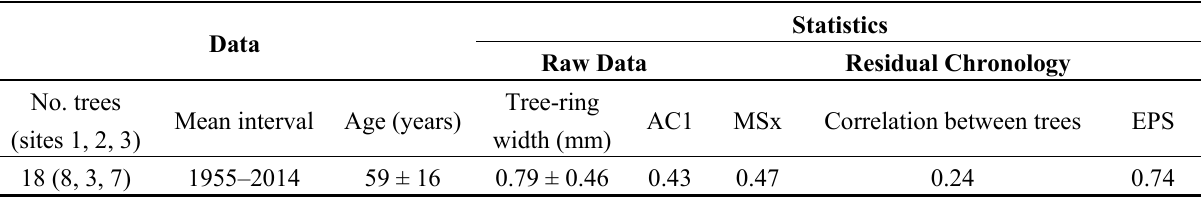
Figure 7. Responses of tree-ring width indices (period 1960–2014) to climate: monthly mean maximum (TMx) and minimum (TMn) temperatures and total precipitation ( a ), the SPEI drought index calculated for 1–16-month-long scales ( b ) and daily climate data averaged (temperatures) or summed (precipitation) for 5-, 15- and 25-day-long scales ( c ). All plots show Pearson correlations. In figures ( a ) and ( c ) the dashed and dotted lines indicate 0.05 and 0.01 significance levels, whereas in ( b ) the box indicates correlations with p < 0.05. In ( a ) correlations were calculated from previous October to current September and the months previous to the year of tree-ring formation are abbreviated by lowercase letters. In ( b ) the months are indicated along the y- axis, whilst in ( a ) and ( c ), correlations are shown along the y -axis. DOY—day of the year. Table 2. Dendrochronological data and statistics (AC1, first-order autocorrelation; MSx: Mean sensitivity; EPS: Expressed Population Signal) of the holm oak tree-ring width